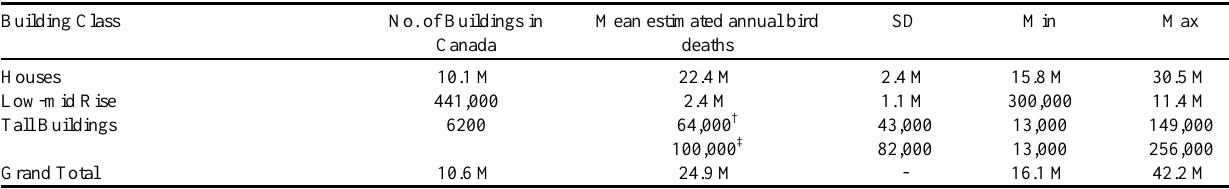
Table 5 . Summary of the estimates of bird mortality caused by bird-window collisions at different types of buildings in Canada.